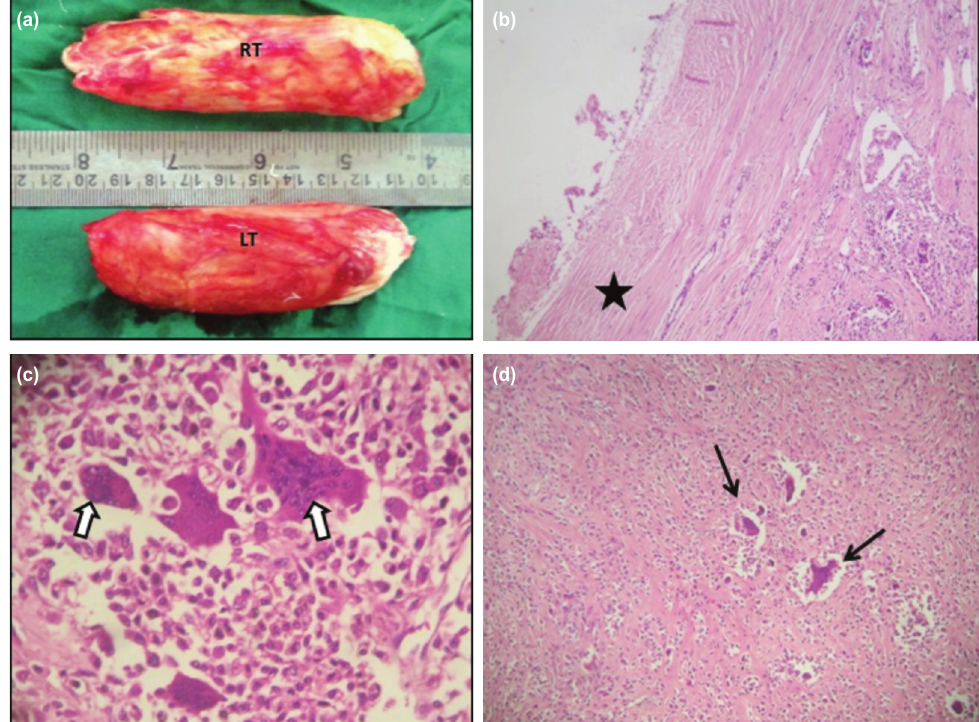
(a) Macroscopic photograph showing both right (11.5×3×2.5cm) and left (9.5×3.5× 2.5cm) side tumour mass with well Fig. 3: circumscribed, smooth encapsulated, yellow-orange-red colour (b) Microscopic low power (haematoxylin and eosin, x5) view of GCTTS reveals well encapsulated tumour with thin fibrous capsule around it. (c) High-power (haematoxylin and eosin, x50) view of GCTTS demonstrating scattered groups of mononuclear cells with occasional osteoclastic multinucleated giant cells (white arrows), accumulation of histiocytes and hemosiderin laden macrophages are also seen. (d) Low-power view (haematoxylin and eosin, x10) of GCTTS reveals a prominent number of mononuclear cells with scattered multinucleated giant cells